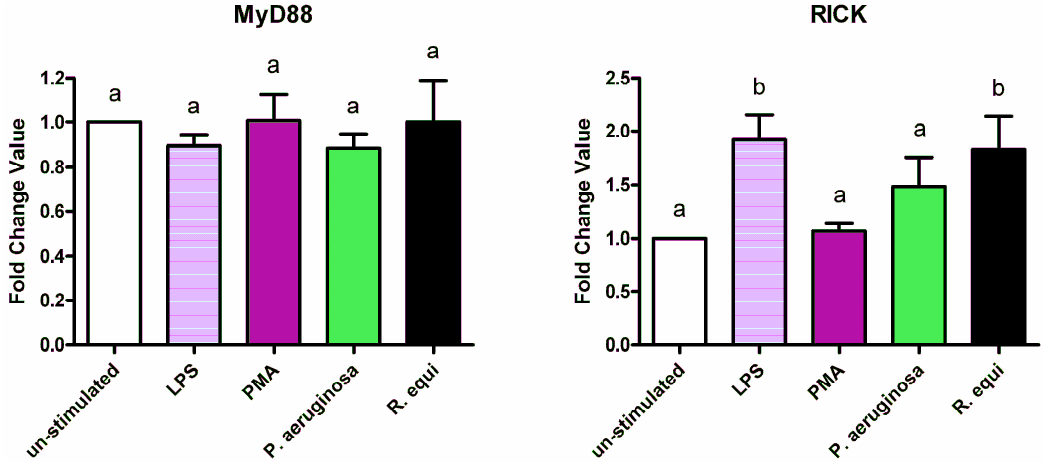
Figure 9. Expression of the MyD88 and the RICK mRNA by RAW264.7 macrophages cultured in basic medium after 24 h of stimulation with LPS, PMA, P. aeruginosa ATCC 10145 and R. equi ATCC 33701 respectively. Data are mean ± SD ( n = 6). Bars denoted by different letters are significantly